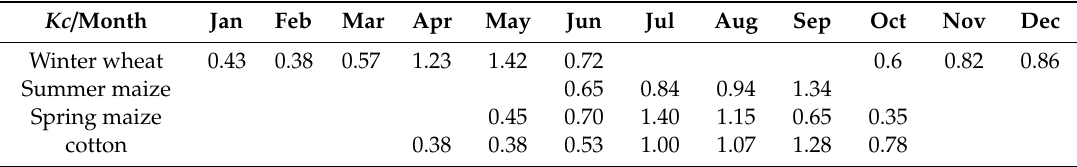
Table 1. The crop coe ffi cient ( K c ) values of di ff erent